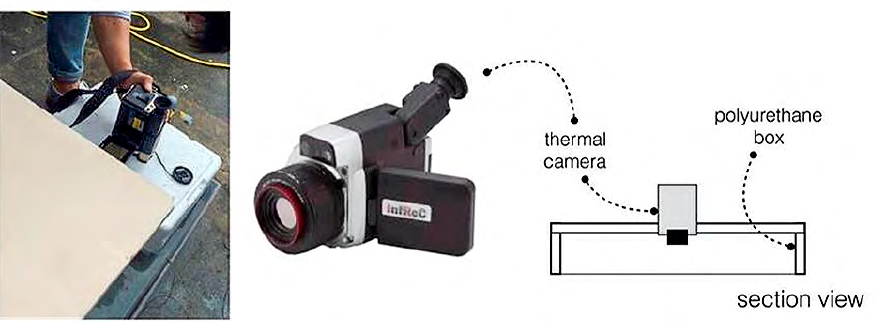
Figure 3. Surface temperature monitoring equipment and